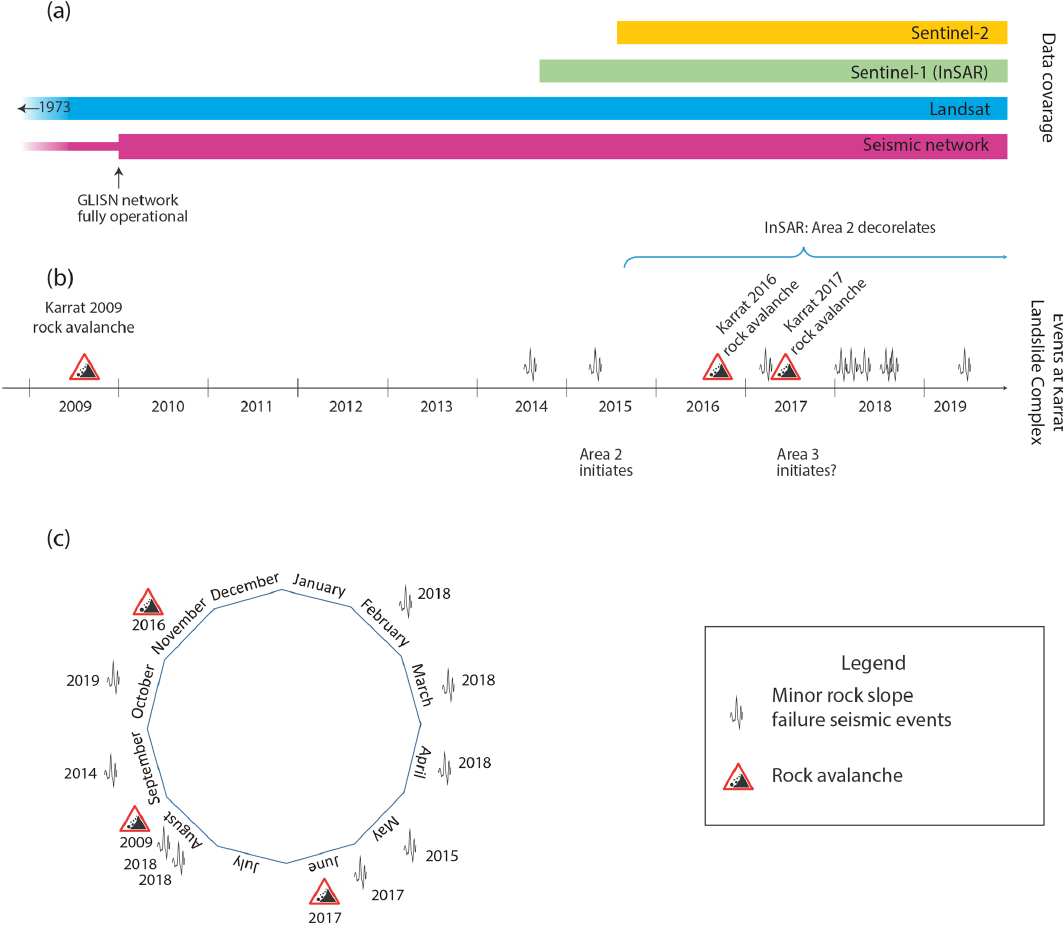
Figure 8. (a) Data coverage, (b) timeline of recent events in the Karrat Landside Complex, and (c) yearly distribution of rock slope failures and seismic